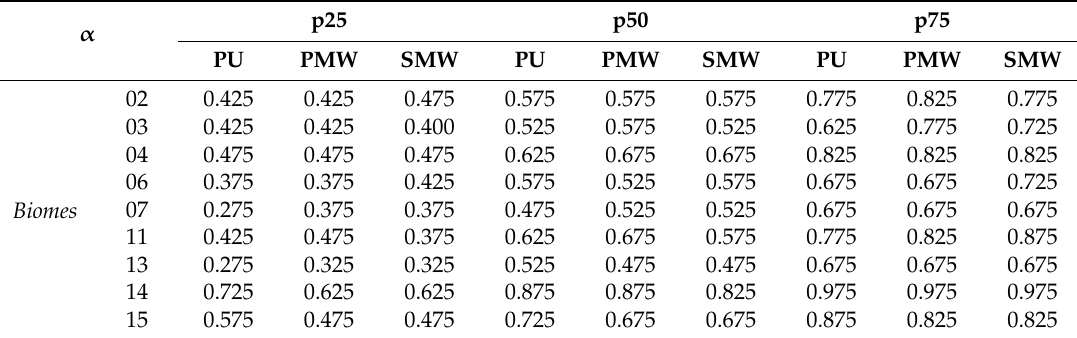
Table 1. First quartile (p25), median (p50), and third quartile (p75) of the distribution of α as estimated with PU LST (PU), CM-SAF PMW LST (PMW), and CM-SAF SMW LST (SMW) for the different biomes (identified by the labels described in Figure